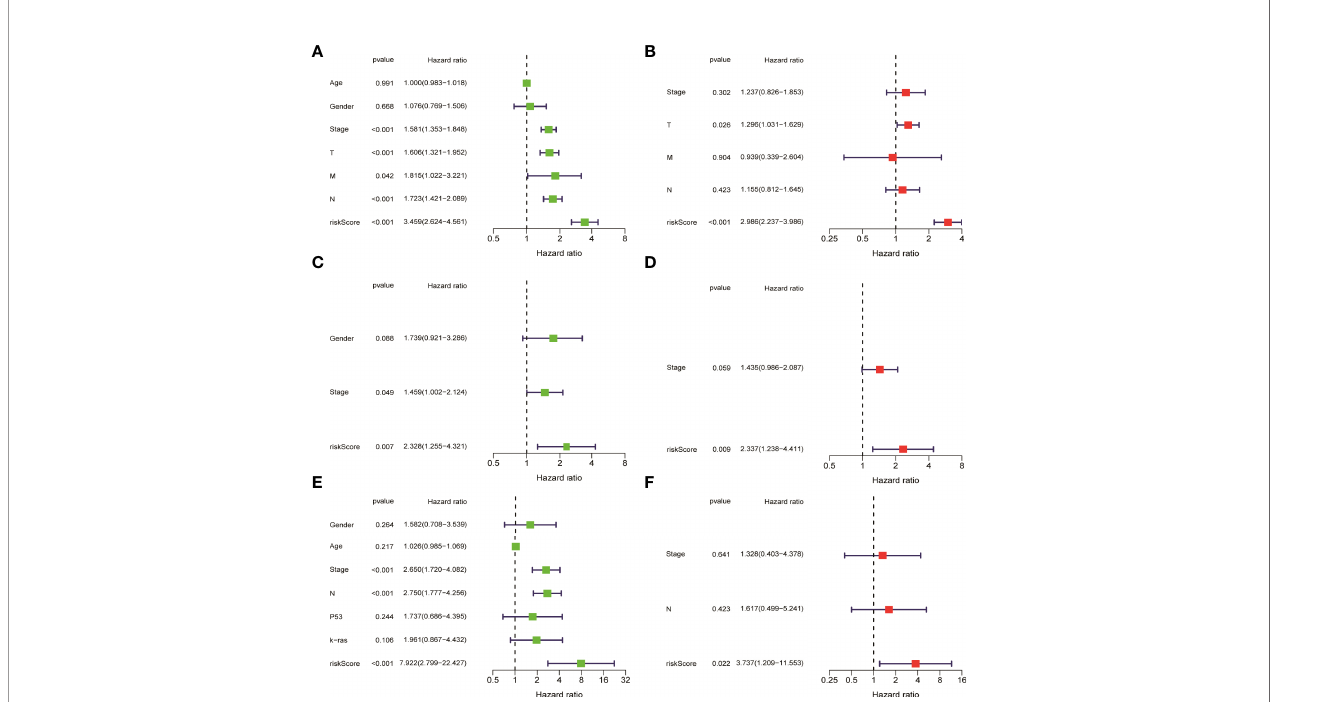
FIGURE 4 | Univariate cox analysis and multivariate Cox analysis veri fi ed that the risk score of the model was an independent prognostic risk factor. (A, B) TCGA LUAD. (C, D) GSE42127. (E, F) GSE68571.